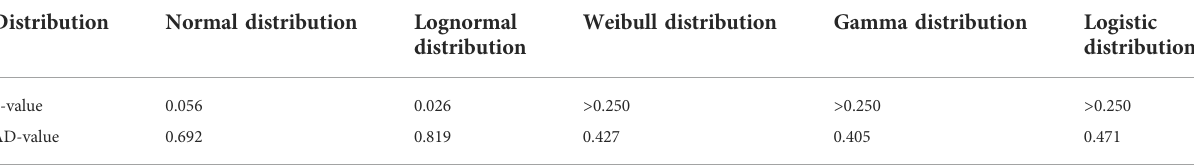
TABLE 5 Comparison of fi t of different